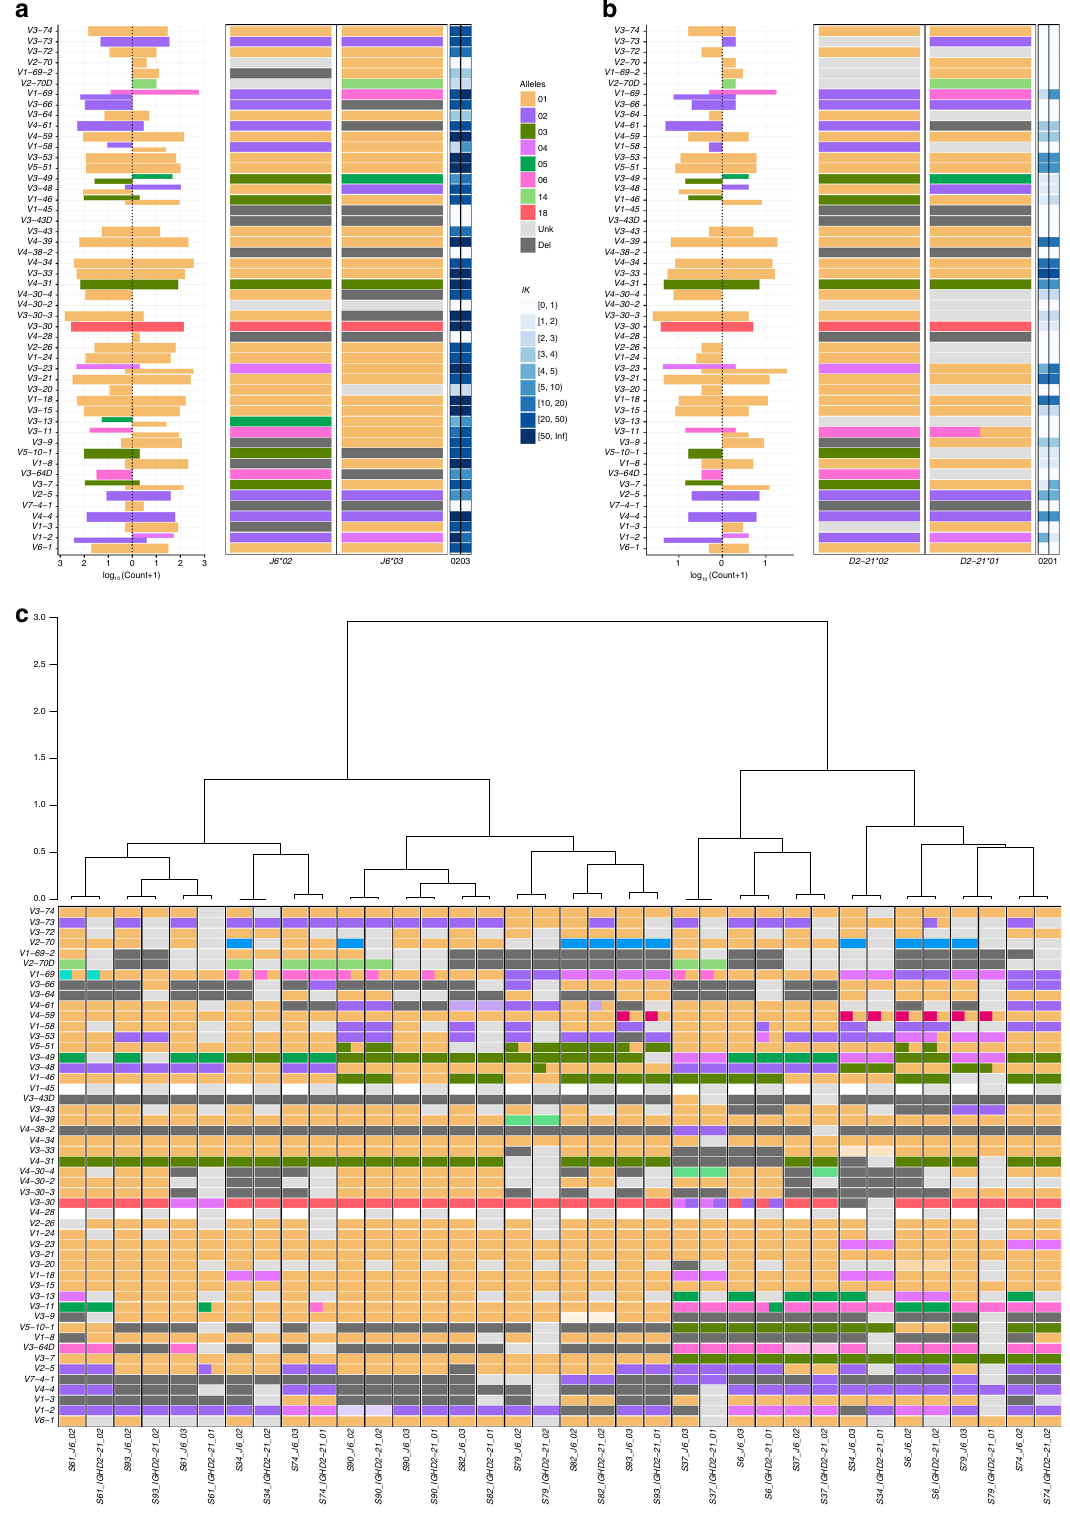
Fig. 7 D -based haplotype inference. a Example for V haplotype by J6 . The cutoff between an unknown and a deleted gene on a certain chromosome was determined by lK > = 3 (see Methods). b Example for V haplotype by D2-21 , for the same individual as in a . c V haplotype map in which each column corresponds to a J6 -based or D2-21 -based haplotype of an individual that is heterozygous for both these genes. The order of columns was determined by a hierarchical dendrogram based on the distances between individual haplotypes